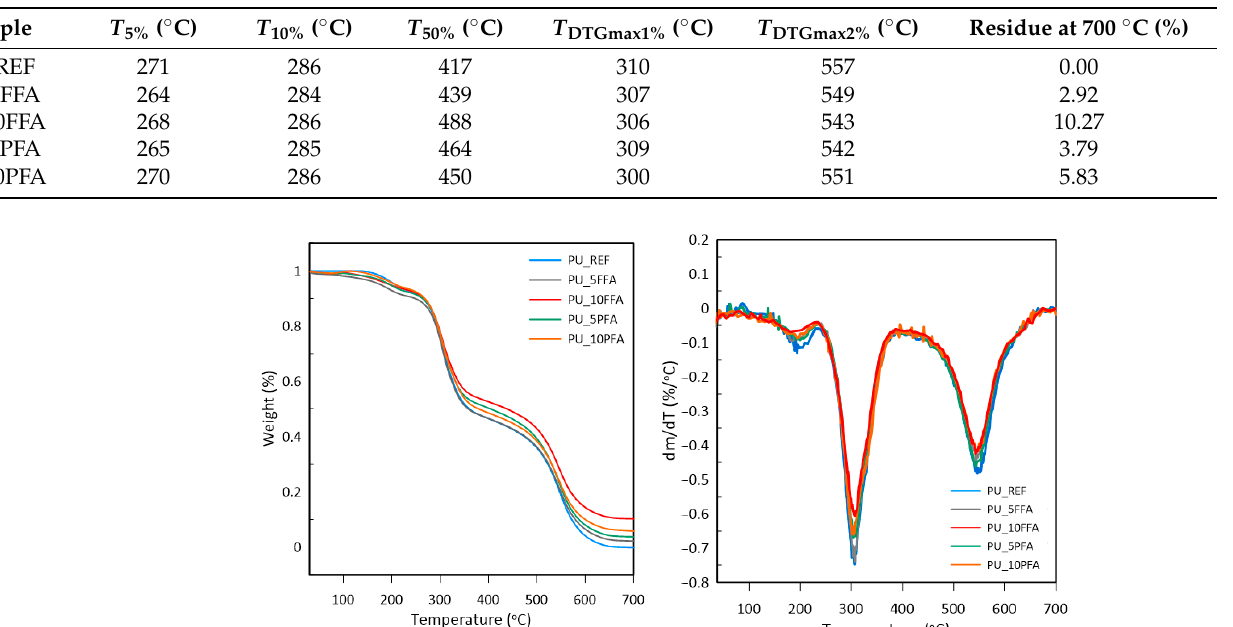
Table 3. Thermal degradation parameters of RPUF composites.